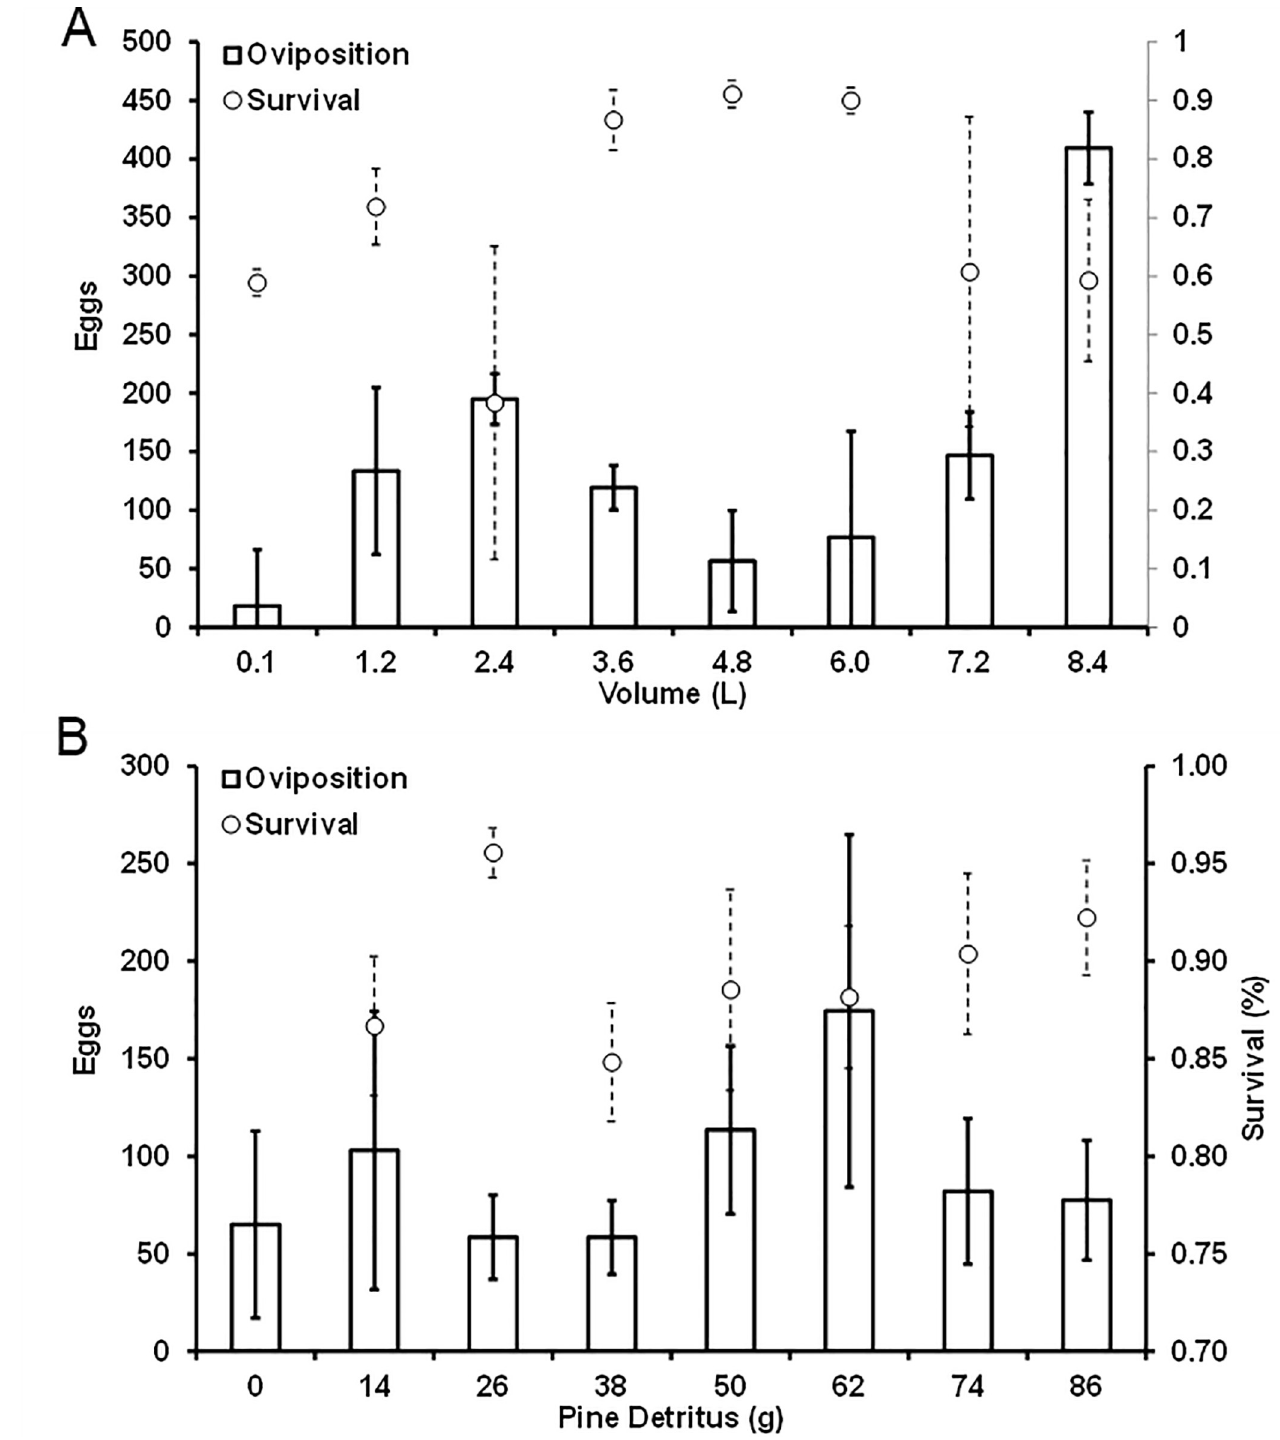
Fig 1. Results (raw means ± SE, dashed for survival, solid for oviposition) from separate experiments examining how environmental factors affect oviposition responses (n = 4 replicates) and larval survival (n = 3 replicates) of Aedes albopictus . A. Response to different water volumes in tires, and B. response to different quantities of pine needle